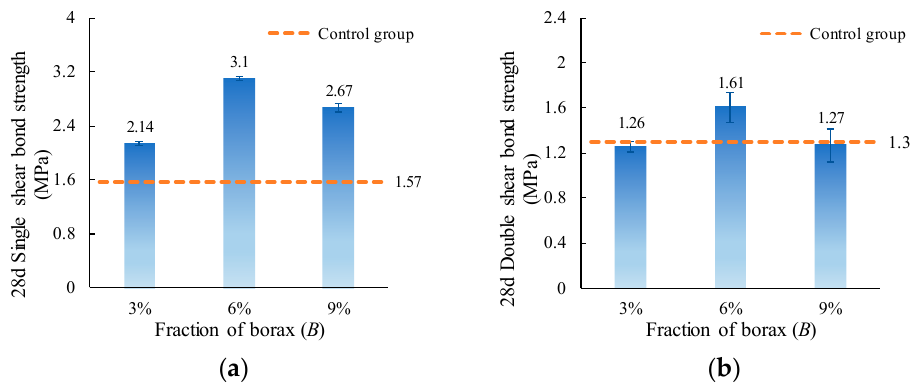
Figure 9. ( a ) Single shear bond strength and ( b ) double shear bond strength of specimens with varying borax content ( B ).